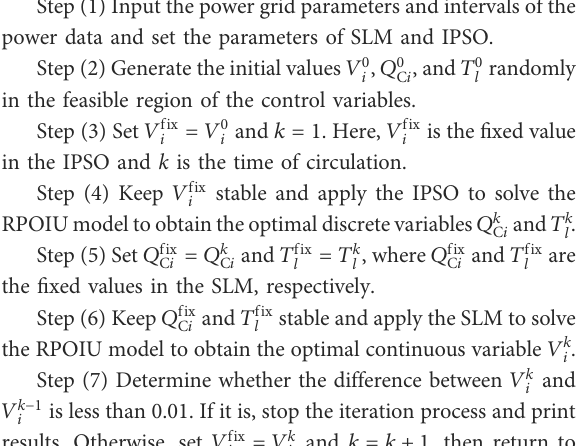
Figure 2. The active power generation and related variable ranges of the generators are shown in Table 1. The settings of the capacitors are shown in Table 2. The voltage magnitudes of the load buses were limited to the range of [0.95, 1.05]. The a step of 0.05. The parameters of SLM and IPSO are set as follows. The iteration precision ε (cid:2) 10 − 4 in SLM. The number of iterations Size (cid:2) 100, the population size M = 50, the learning factors c1 = c2 = 2, the initial inertia weight ω ini (cid:2) 0 . 9, and the fi nal inertia weight ω (cid:2) 0 . 1 in IPSO. end